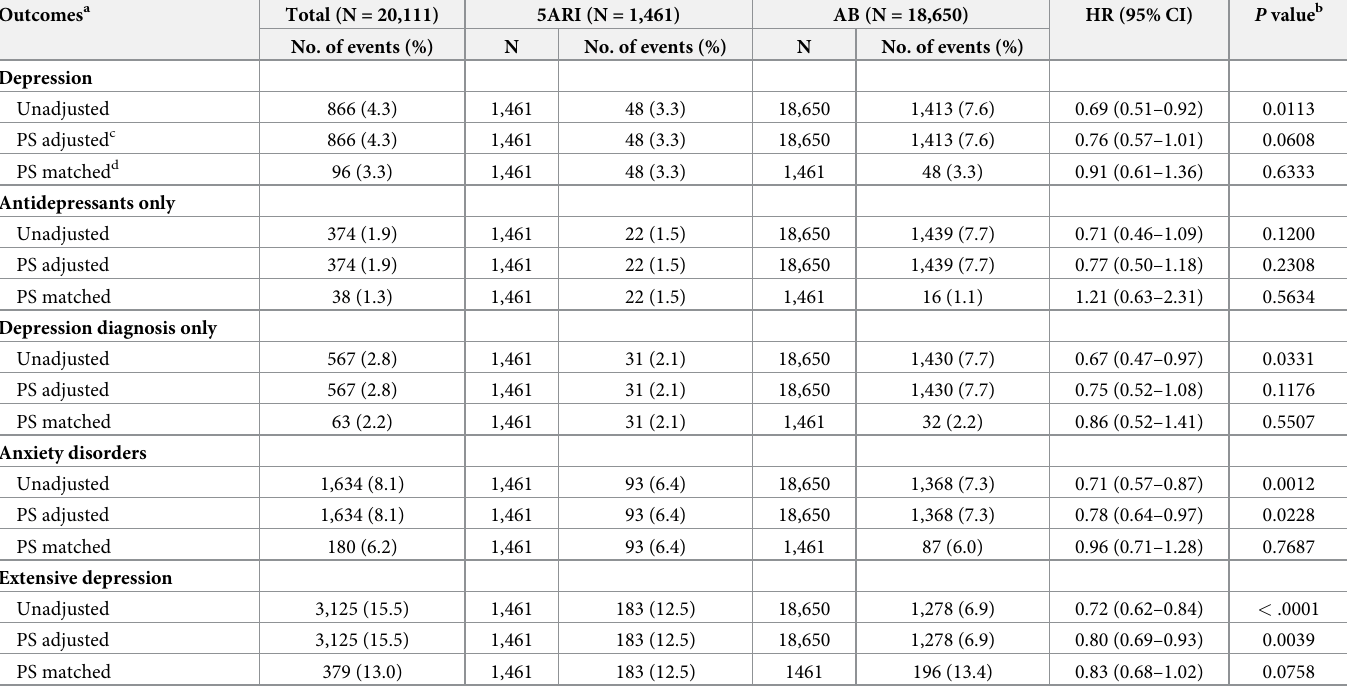
Table 2. Risk of depression and anxiety disorders among BPH patients exposed to 5ARI versus